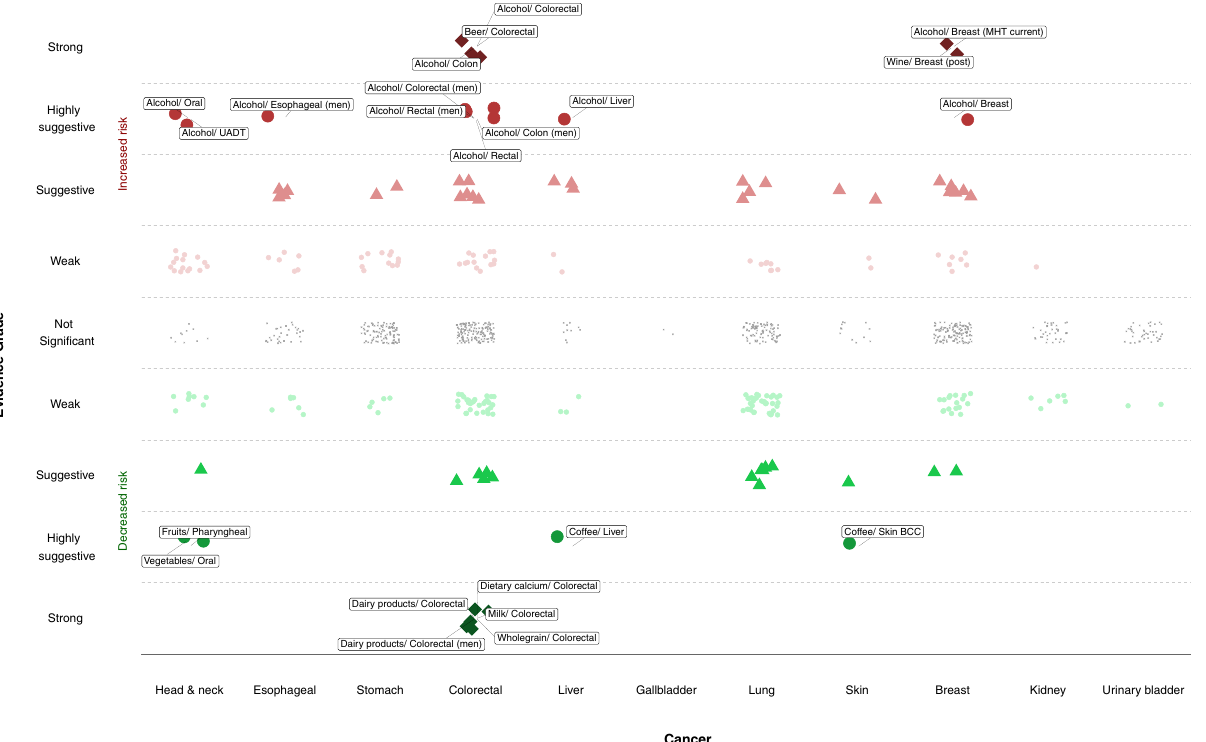
Fig. 1 Scatter plot showing results from the umbrella review grading the evidence on diet and cancer risk. The Y -axis shows the strength of the evidence. The upper half displays associations that increase cancer risk (in red), whereas the bottom half shows associations that reduce cancer risk (in green). The different point symbols and color intensity represent the different levels of evidence grading. Points colored in gray denote no statistically signi fi cant associations. The X -axis corresponds to the different cancer sites. BCC basal cell carcinoma, MHT menopausal hormone therapy, UADT upper aerodigestive